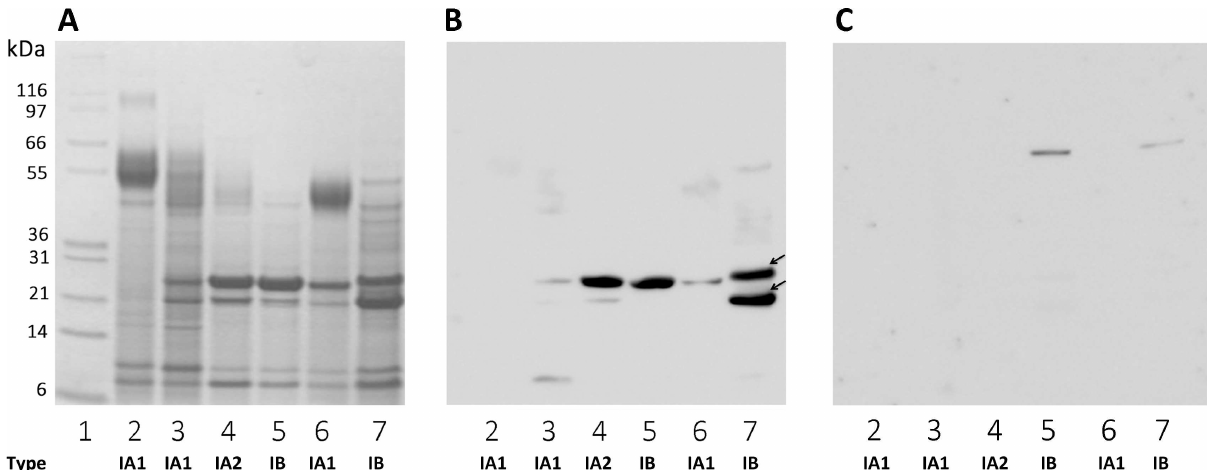
Fig 3. TLR2 binding to P . acnes surface proteins. P . acnes surface proteinswere extracted from a 5-day culture bacterial pellet and separated by electrophoresis in a 4–12%NuPAGE LDS BisTris gel (50 μ g) with detectionby Coomassie blue staining (A). Separated proteins were transferred onto nitrocellulose membranes, which were incubatedwith recombinant TLR2 (B) and TLR4 (C) (0.1 μ g/ml). TLR binding activity was detected with specific biotinylatedantibodies against TLR2 and TLR4, respectively, as describedin the Materials and Methods. Lane 1 containsthe molecularmass markers. Lanes2 to 7 contain proteinsfrom strains 6919, RON, CHR, GUE, TRI, and PIE, respectively. Arrows indicate the positionsof the 24.5- and 27.5-kDabands of interest.